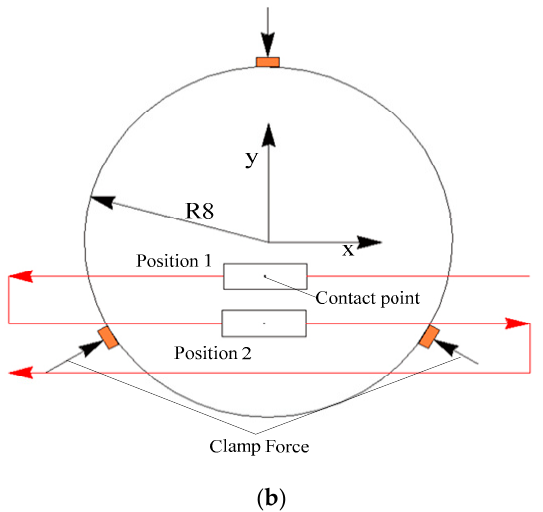
Figure 1. Linear track grinding. ( a ) Sketch of linear grinding; ( b ) Diagrammatic drawing of linear track.